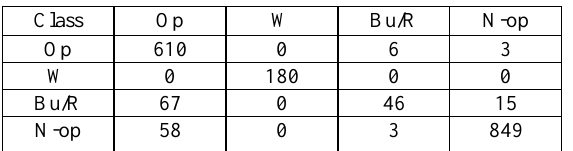
Table 2. Confusion matrix produced in Python